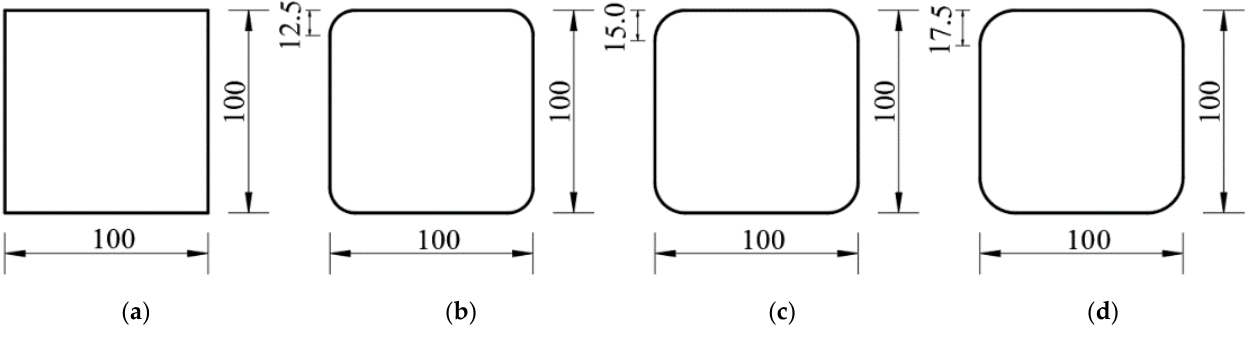
Figure 10. Sections of MDOF model with rounded corner (unit: mm): ( a ) rounded ratio 0%; ( b ) rounded ratio 2.5%; ( c ) rounded ratio 5%; ( d ) rounded ratio 7.5%.